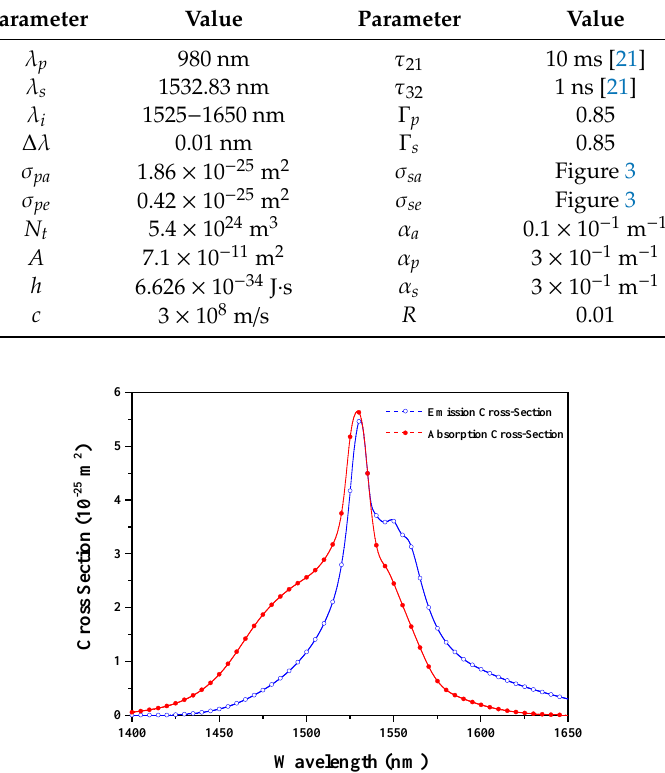
Table 1. Intracavity laser (ICL) parameter used in the calculation.